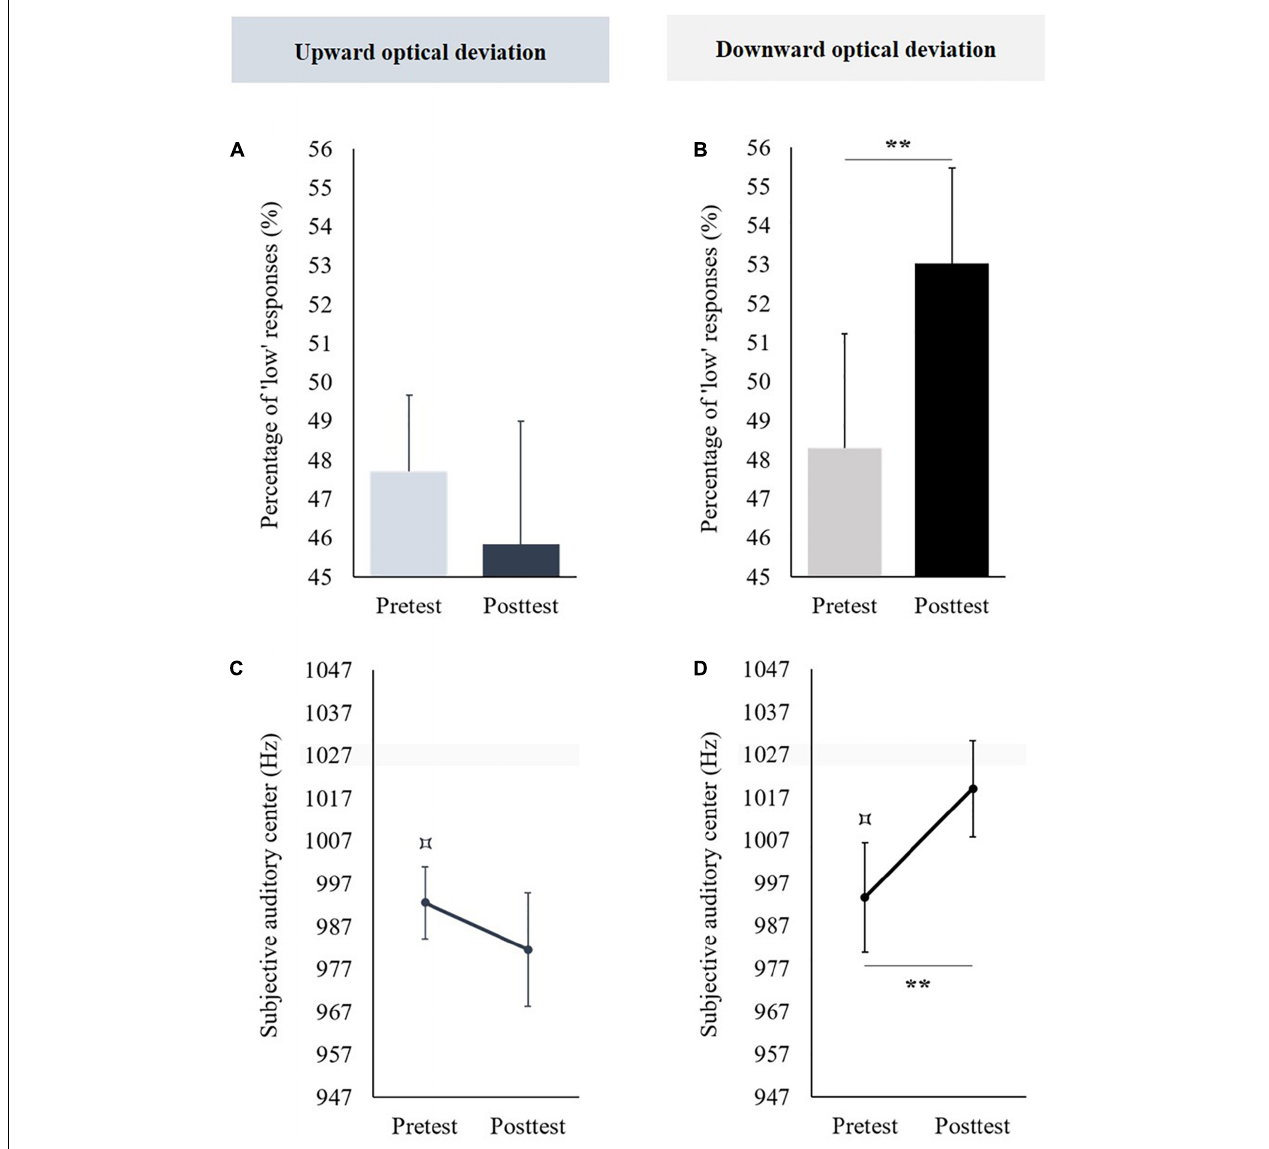
FIGURE 6 | Aftereffects of vertical prism adaptation on auditory frequency representation. Data obtained in the group using an upward optical deviation are represented in the left part; data obtained in the group using a downward optical deviation are represented in the right part. Panels (A,B) display the percentage of “low” responses before (pretest) and after (posttest) vertical prism adaptation. Panels (C,D) display the subjective visual center before (pretest) and after (posttest) vertical prism adaptation. ** p < 0.01. The pretest was compared to 50 % [for the percentage of “low” responses, panels (A,B) ] or 1,027 Hz [i.e., the objective auditory center, panels (C,D) ]: p < ◊